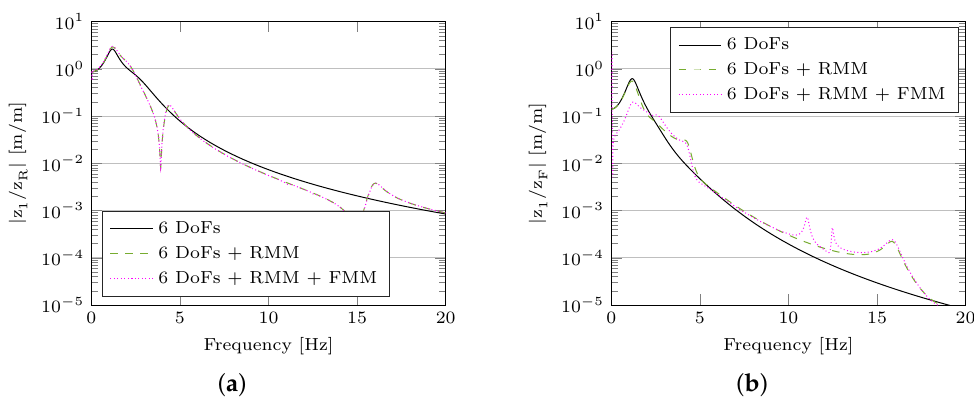
Figure 13. Transmissibility between the wheels of the 6-DoFs tractor and the operator’s seat z 1 with rear-mounted (RMM) operating machine and front-mounted (FMM) operating machine: ( a ) rear wheels z 1 / z R ; ( b ) front wheels z 1 / z F .